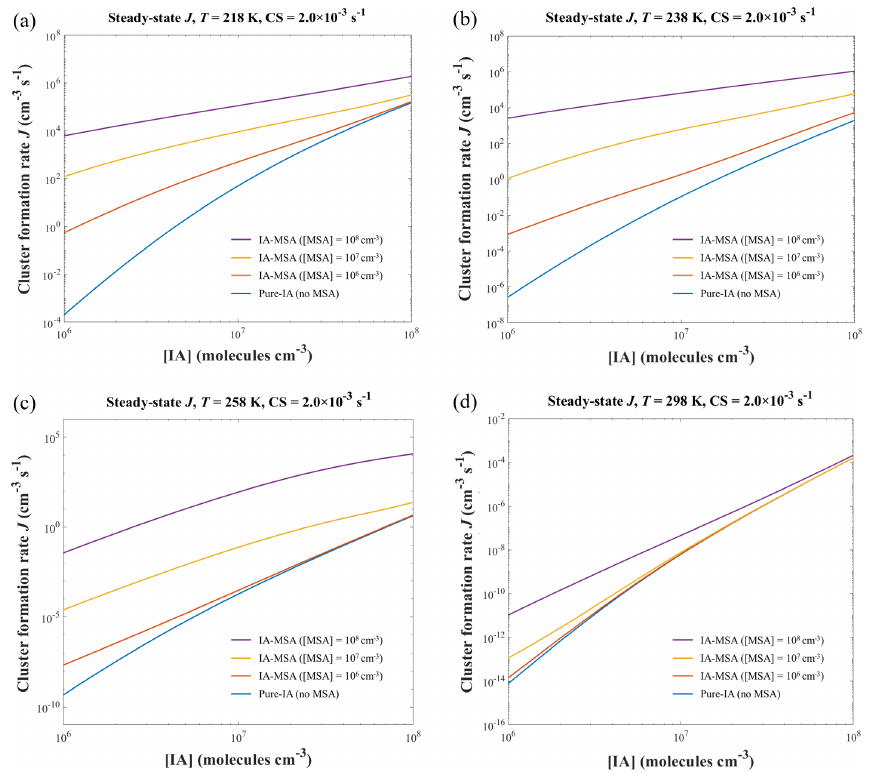
Figure 6. The simulated cluster formation rate J (cm − 3 s − 1 ) of the IA-MSA system at different temperatures (a) 218, (b) 238, (c) 258, and (d) 298K; [IA] = 10 6 –10 8 molec.cm − 3 ; [MSA] = 0, 10 6 , 10 7 , and 10 8 molec.cm − 3 ; and CS = 2 . 0 × 10 − 3 s − 1